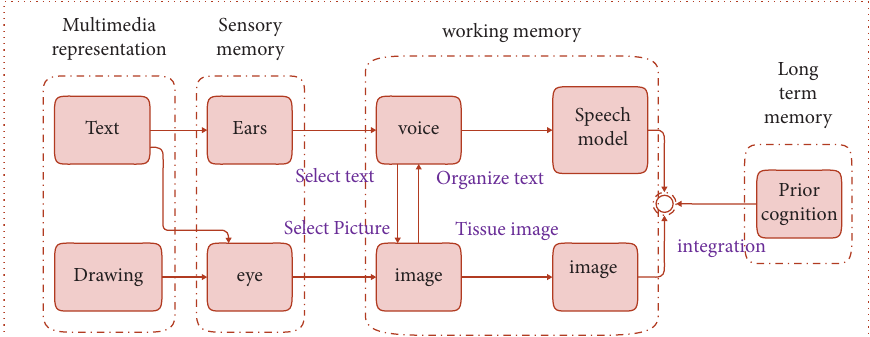
Figure 1: Flowchart of the multimedia cognitive theory model.